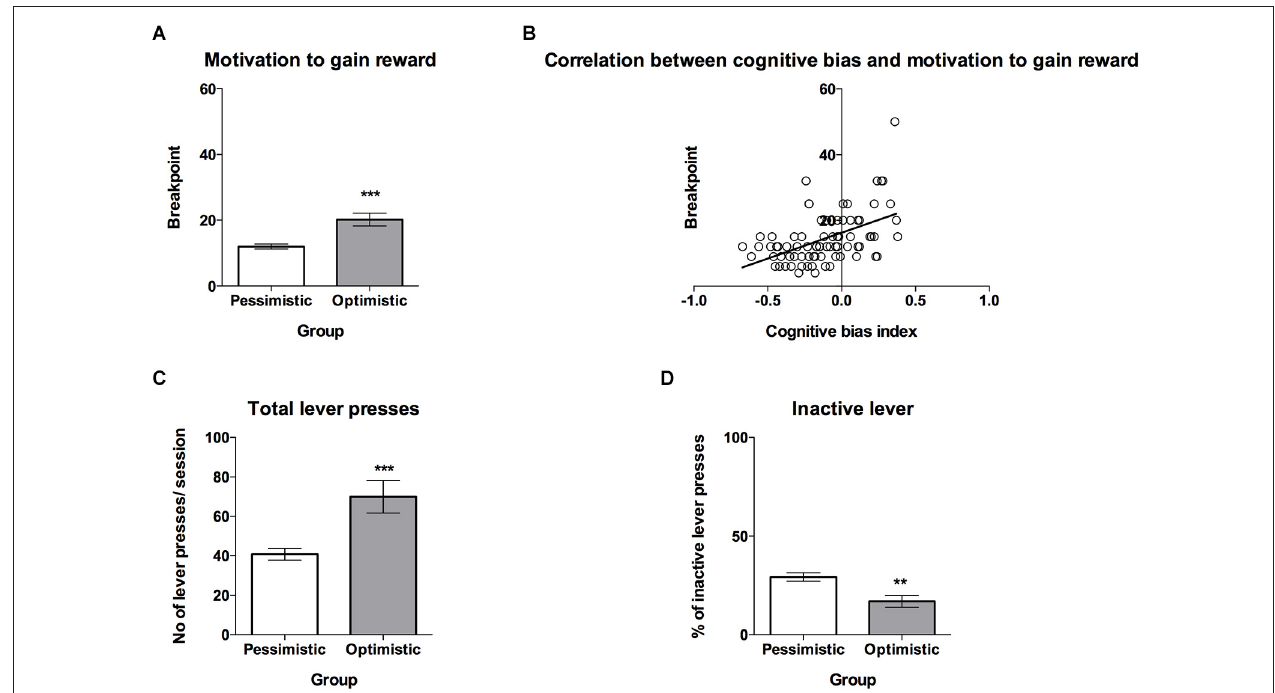
(C) The mean ± SEM for the number of total lever presses made during one PR schedule of reinforcement test session by animals classified as “optimistic” vs. “pessimistic”. (D) The mean ± SEM percentage of inactive lever presses made during one PR schedule of reinforcement test session by animals classified as “optimistic” vs. “pessimistic”. *** indicates significant ( p < 0.001) differences between the “optimistic” and “pessimistic”